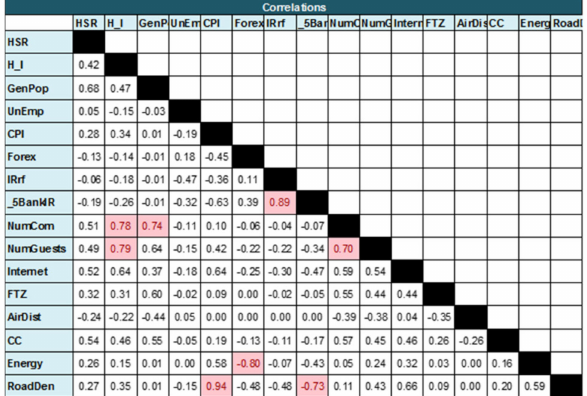
Figure 6. Correlation matrix of the base model